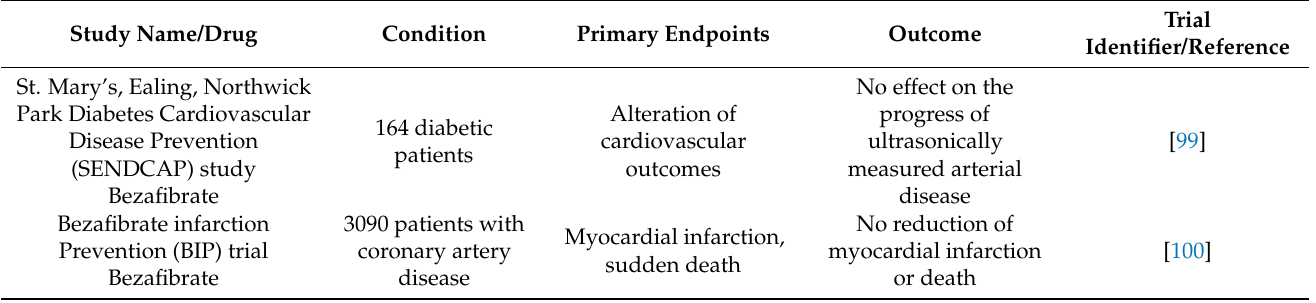
Table 3. Summary of Clinical Trials with pan-or dual ( α / γ ) PPAR agonists for Cardiovascular